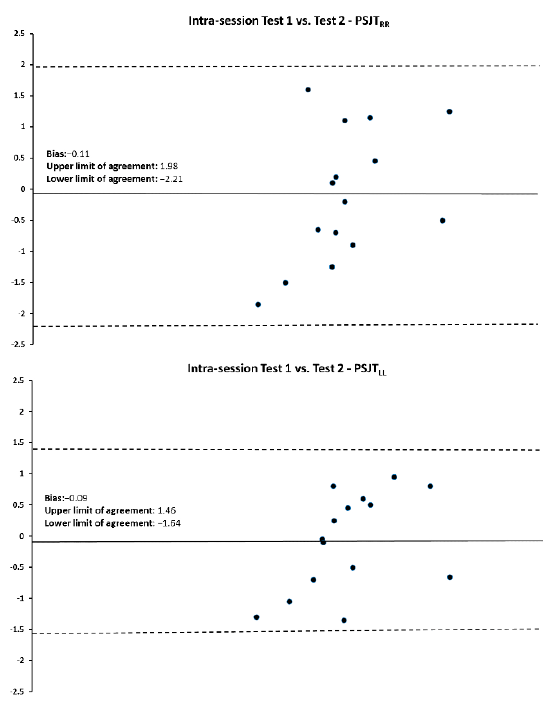
Figure 3. Bland–Altman plot for the intrasession reliability between PSJT RLEG and PSJT LLEG for EGA. The difference between the two measurements per subject is plotted against the mean of the two measurements. The dotted lines represent the upper and lower limits of agreement for 95% CI.